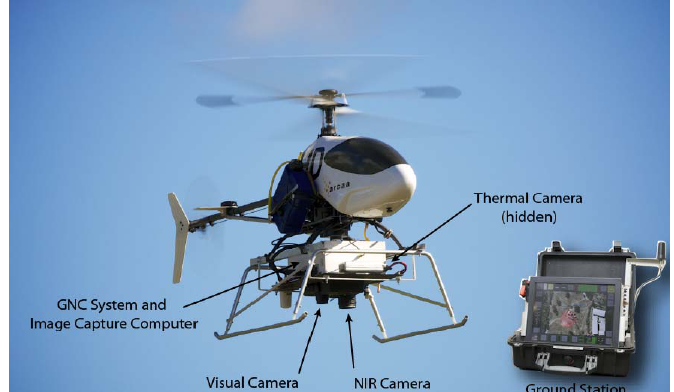
Figure 1. The platform as fitted out for Pheno-Copter work, which can be flown with a radio transmitter only or via a touch-screen control and monitoring ground station